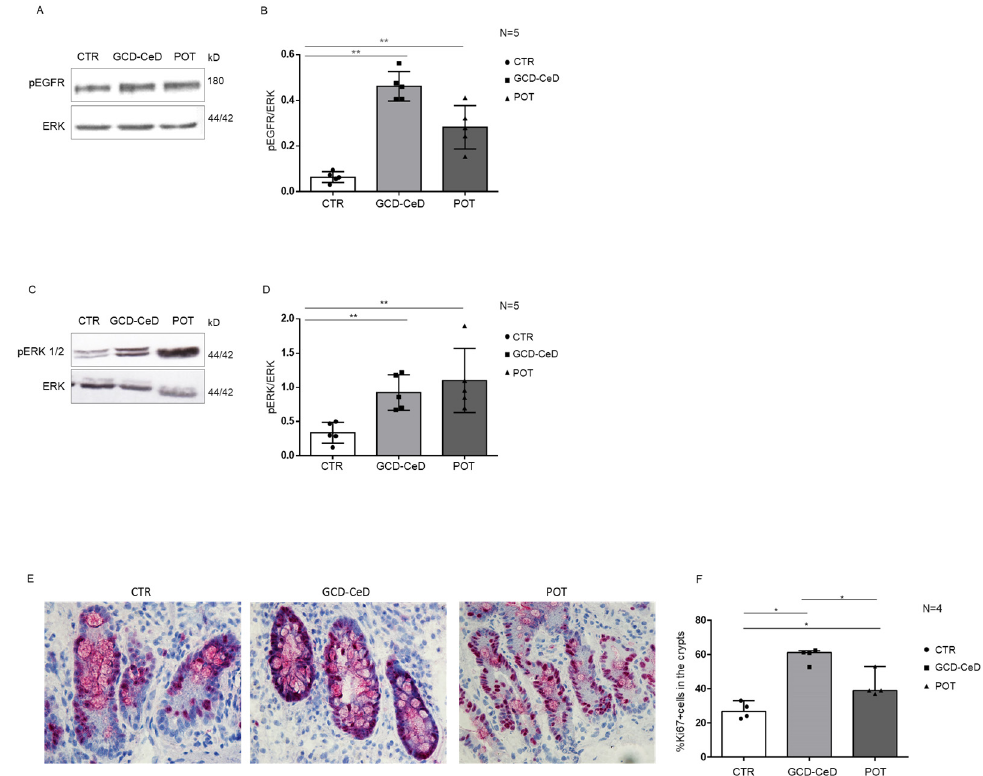
Figure 2. pEGFR, pERK proteins and proliferation are increased in CeD biopsies with low levels of PTPRK. ( A ). Western blot analysis of total protein lysates of intestinal biopsies from CTR, GCD–CeD and Pot–CeD. Upper lines were blotted with an antibody against pEGFR. Bottom lines were blotted with anti-ERK antibodies as loading control. Representative images were selected. ( B ). Densitometric analysis of the pEGFR/ERK bands from CTR, GCD–CeD and Pot–CeD.The numbers of patients analysed are indicated. Columns represent the mean and bars the standard deviation.